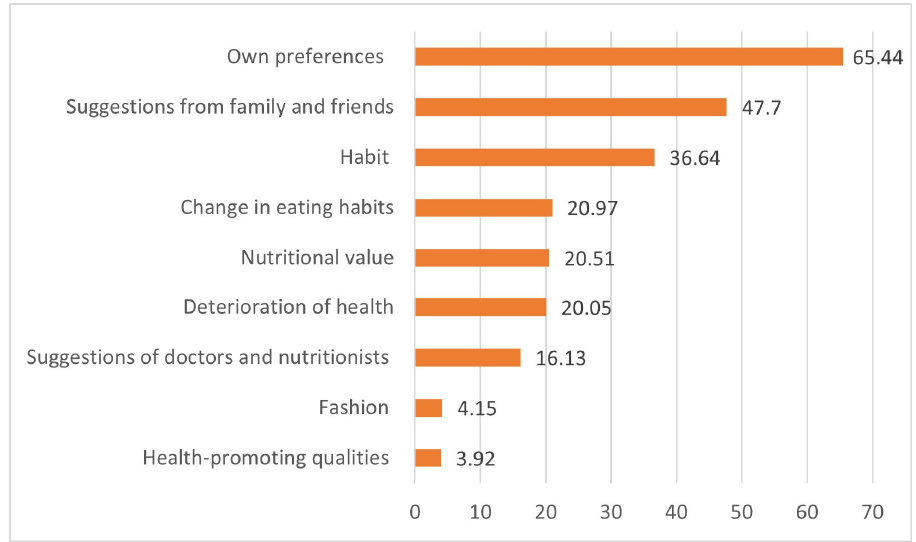
Figure 3. Reasons for consuming honey ( n = 434, data in %).